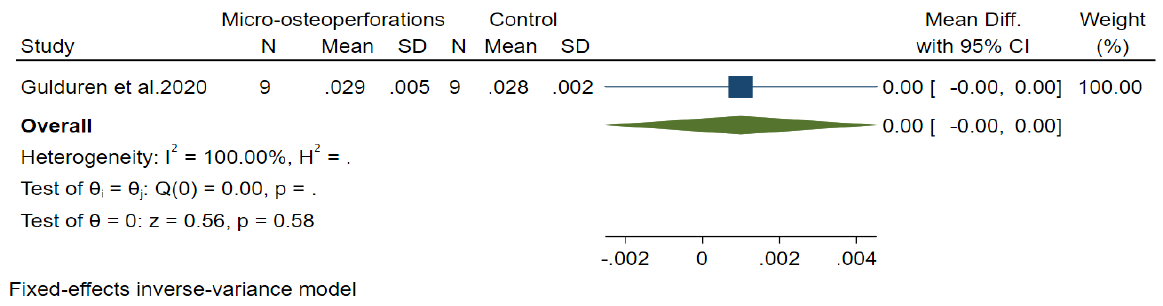
Figure 2. Mean difference of Daily rate of tooth movement with MOP vs. whiteout MOP on miniscrew-supported maxillary molar distalization.